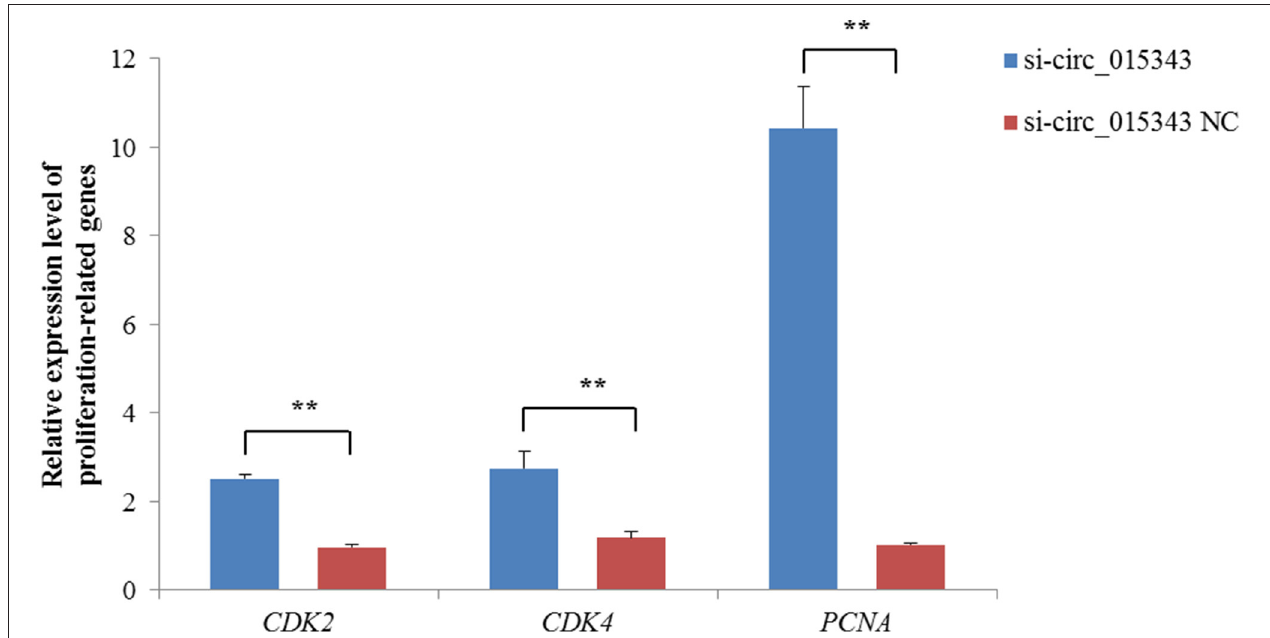
FIGURE 8 | Relative expression levels of proliferation-related genes when si-circ_015343 was transfected into ovine mammary epithelial cells. ** p <